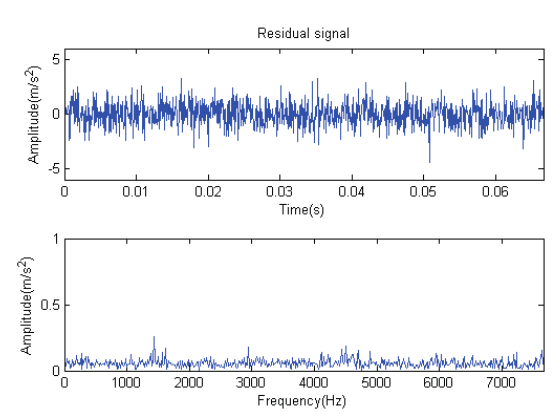
Figure 9. Residual